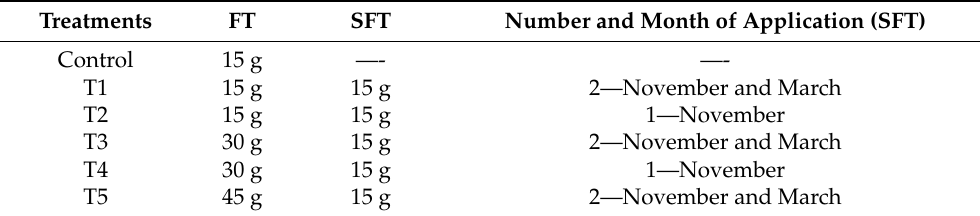
Table 7. Combination of the treatments and fertilizer amounts used. Fertilizer treatments (FT) with supplemented fertilizer treatments (SFT).